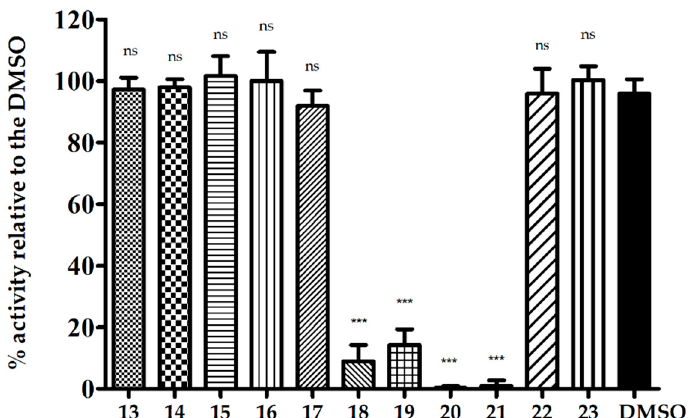
Figure 3. The effect of uridine glycoconjugates on TBEV infection in A549 cells. A549 cells were infected with the TBEV Neudoerfl strain at an MOI of 0.001. At 2 h post-infection (p.i.) the virus was removed, cells were washed and overlaid with carboxymethylcellulose in Dulbecco’s Modified Eagle’s Medium with DMSO or various doses of tested compounds. At 48 h p.i., cells were fixed, and infected foci were visualized by immunostaining with the monoclonal anti-Flavivirus group antigen antibody (4G2). Viral plaques were counted and expressed as percentage in comparison to the number of plaques detected in DMSO-treated infected cells set as 100%. Error bars represent standard deviations from 3 separate experiments. ns: not significant; ***: p < 0.001 compared to infected DMSO-treated cells by one-way ANOVA with Dunnett’s post-test.